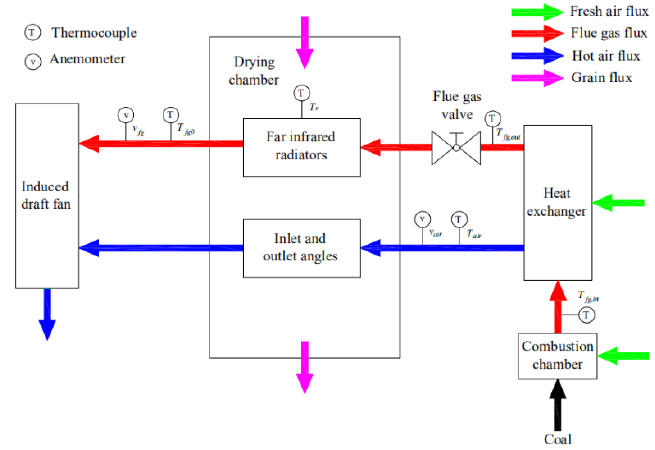
Figure 2. The schematic diagram of the flows for different fluxes. Table 2. The key parameters of the dryer and the heat exchanger.